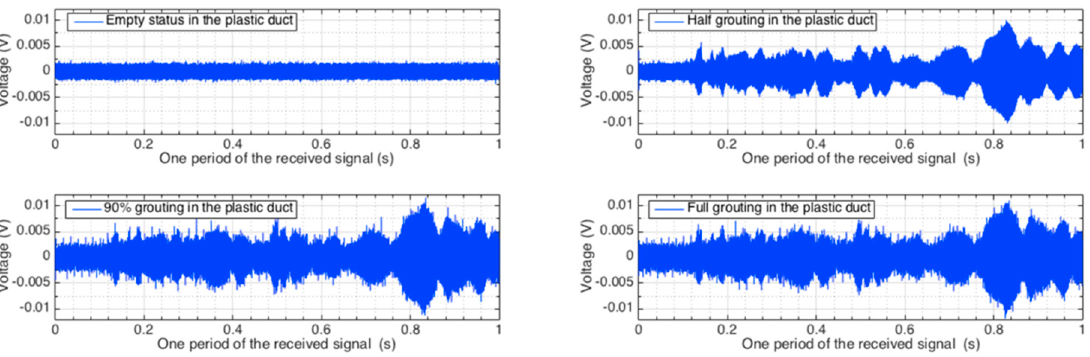
Figure 10. Time-domain signal of PZT 1 sensor in different grout stages.